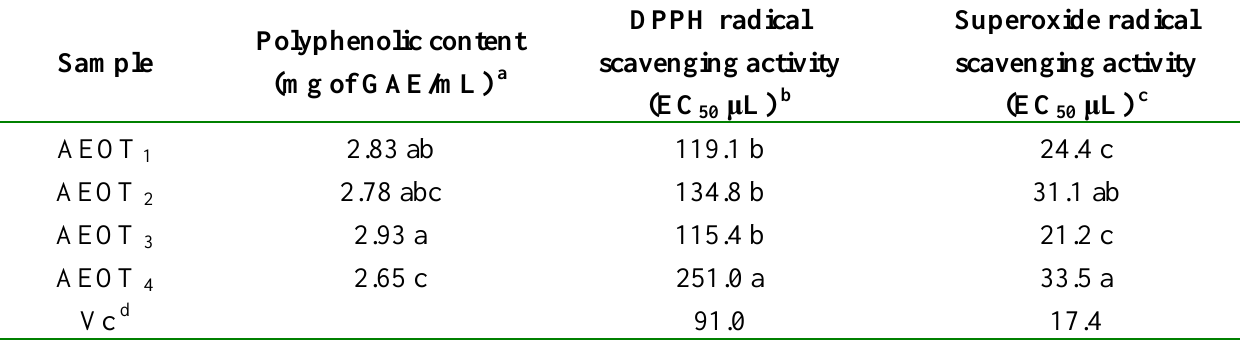
Table 1. Total phenolic content and free radical scavenging activities of